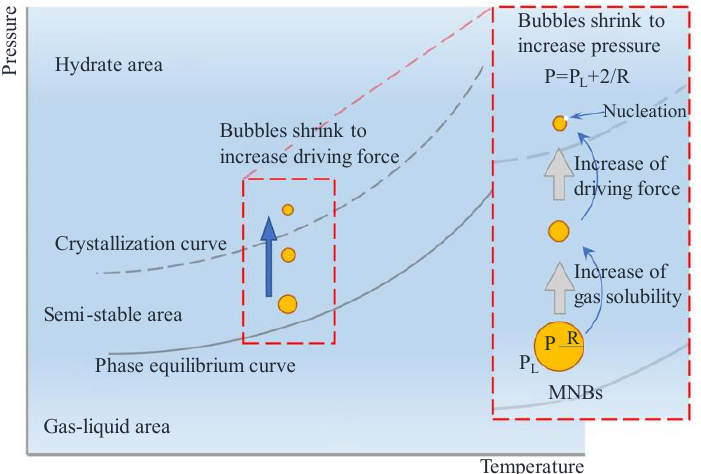
Figure 4. Schematic diagram of increasing the driving force of hydrate nucleation by MNBs